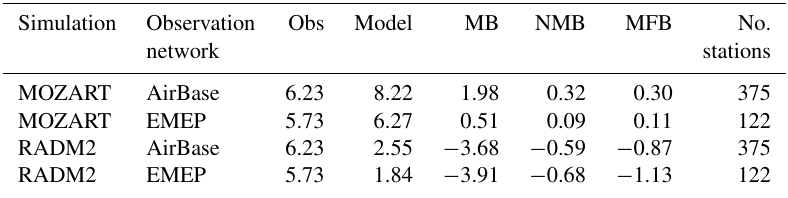
Table 7. Statistics for yearly SOMO35 in mgm − 3 multiplied by